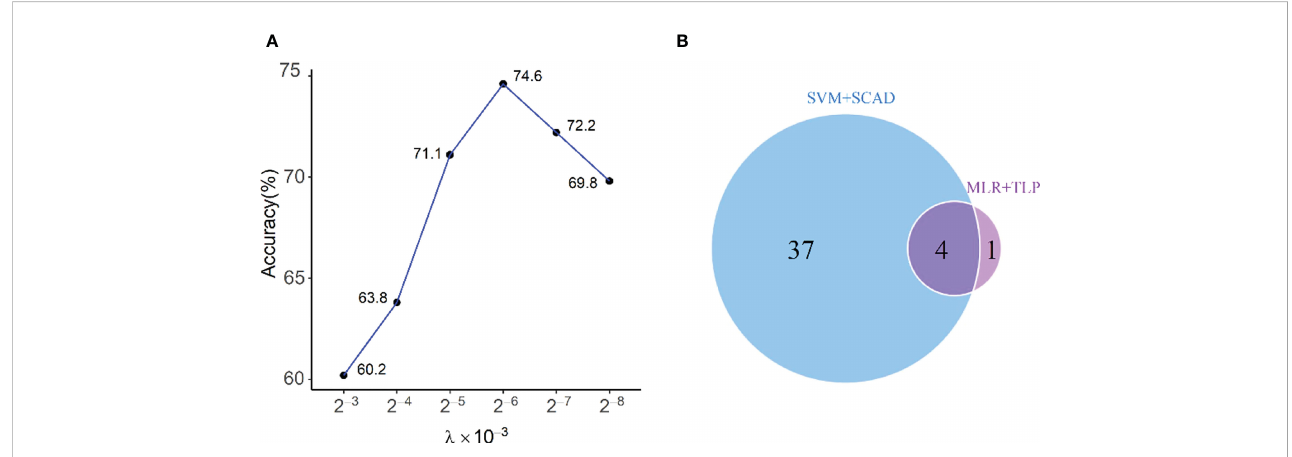
FIGURE 3 (A) Selecting l in MLR+TLP using leave-one-out cross-validation; (B) Venn diagram shows the relationship between chosen variables by MLR+TLP and SVM +SCAD. The four variables selected by the two methods are L%, ALB, N%, and C4, and the one elected only by MLR+TLP is Vcl, which is very